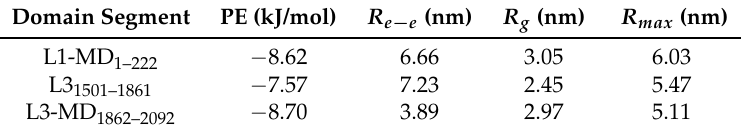
Table 2. Properties of the molecular-dynamics (MD)-optimized structures of domains L1 and L3: potential mass R max